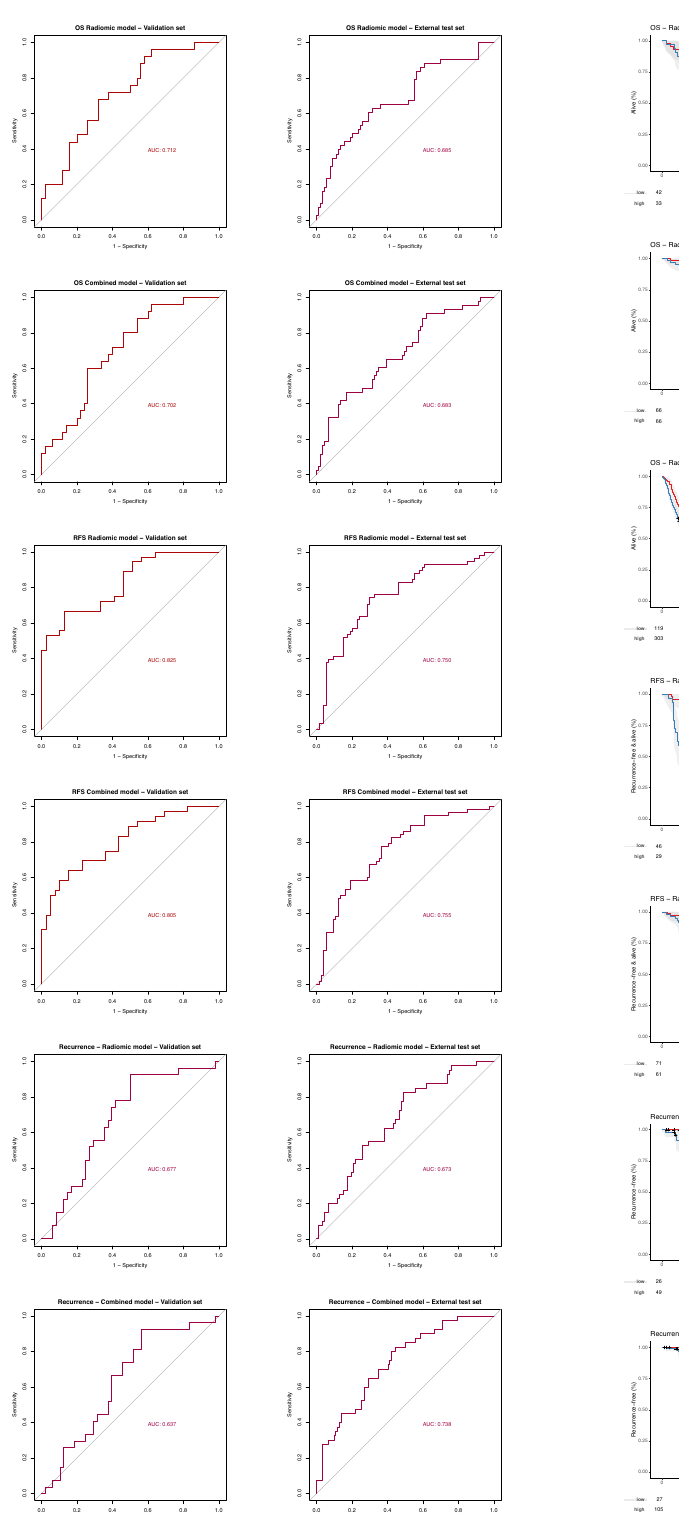
Fig. 4 ROC curves for the validation and external test sets for the Radiomic and Combined models for each prediction. The fi nal models were, for OS: Spearman correlation with PLS, for RFS: Pearson correlation with PLS and for recurrence: PCA with an ensemble of PLS, KNN and Elastic Net.